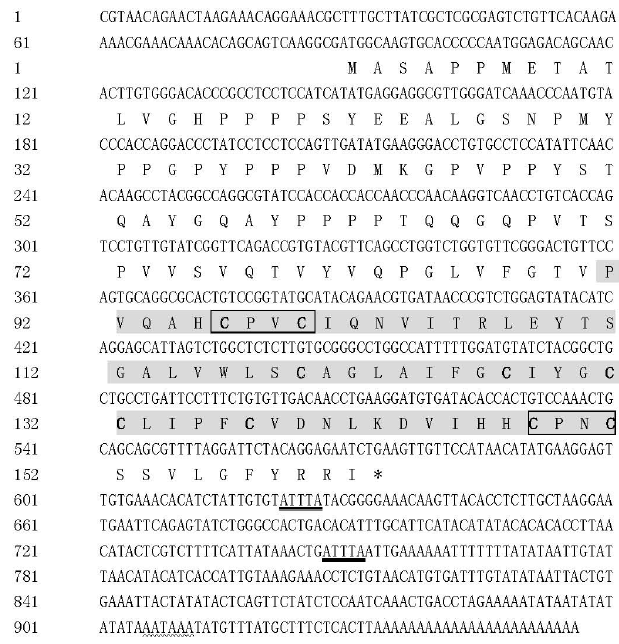
Figure 1. The nucleotide and deduced amino acid sequences of Malitaf . The predicted lipopolysaccharide induced TNF α factor (LITAF) domain is shaded. The two CXXC motifs are in shaded boxes, and the cysteine residues are indicated in shaded bold face. The ATTTA and AATAAA are double and wavy underlined, respectively. “*” shows stop codon.